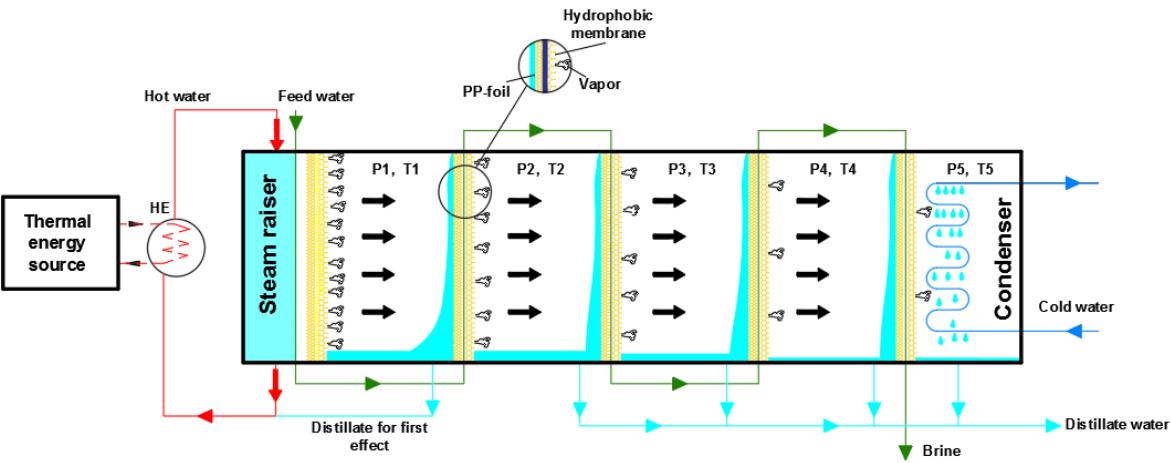
Figure 2. Schematic diagram showing the principle of V-MEMD.